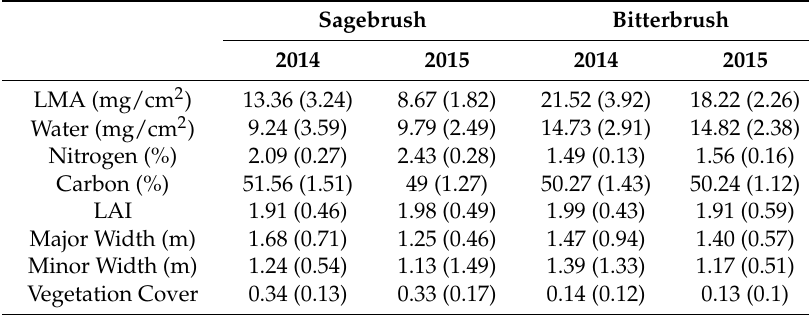
Table 1. Mean and standard deviation (in parenthesis) of foliar biochemical traits, leaf area index, major width, minor width, and vegetation cover of sagebrush and bitterbrush.